Question: Which visualization type does this figure use?
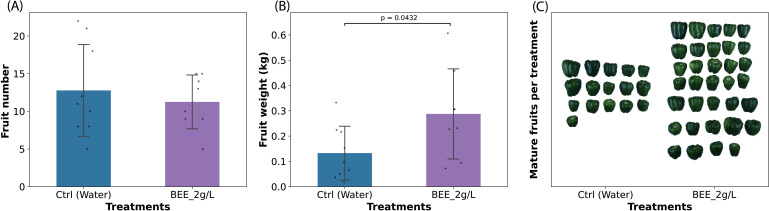
Answer: bar